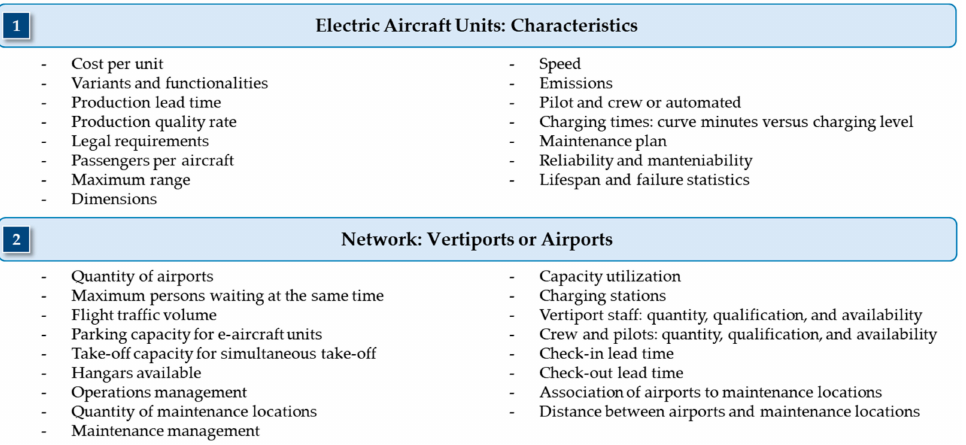
Figure 6. Electric Aviation Mobility Elements.